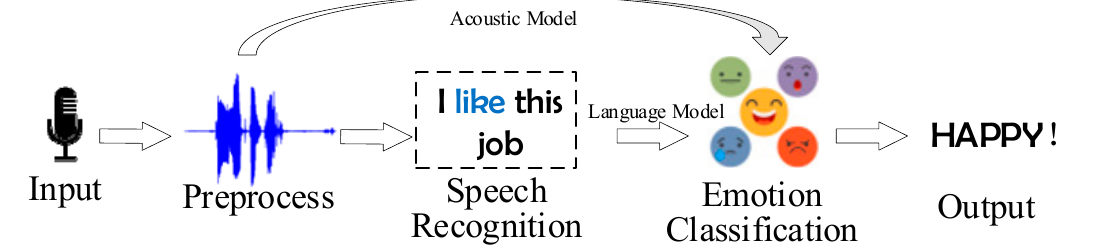
Figure 5. The process of SER.